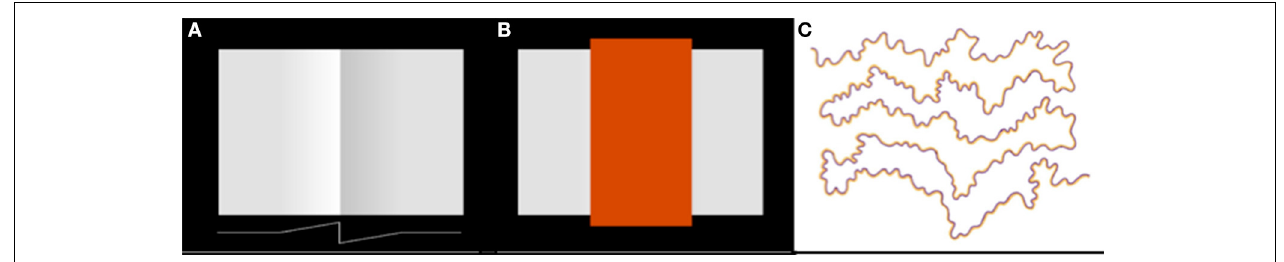
FIGURE 4 | Examples of lightness and color filling-in phenomena. (A) Craik-O’Brien-Cornsweet illusion. The vertical luminance edge at the center of the figure generates a lightness illusion that appears to fill in the regions on either side of the edge, filling in the region on the dark side of the edge with darkness and the region on the light side of the edge with lightness. A one-dimensional horizontal cross-section of the actual